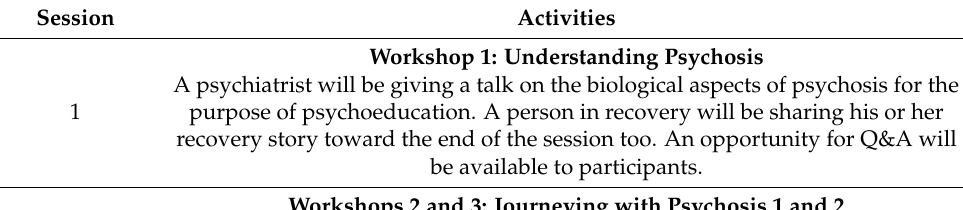
Table 1. A table to summarize the gist of every workshop in the Broken Crayons workshop